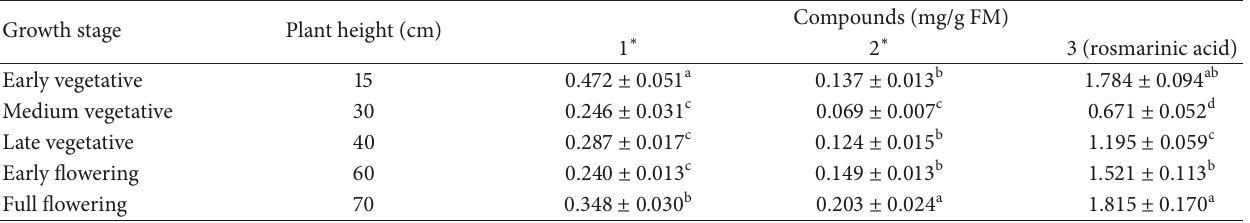
Table 3: Individual phenolic compounds in the perilla fresh matter (FM) at different growth stages.